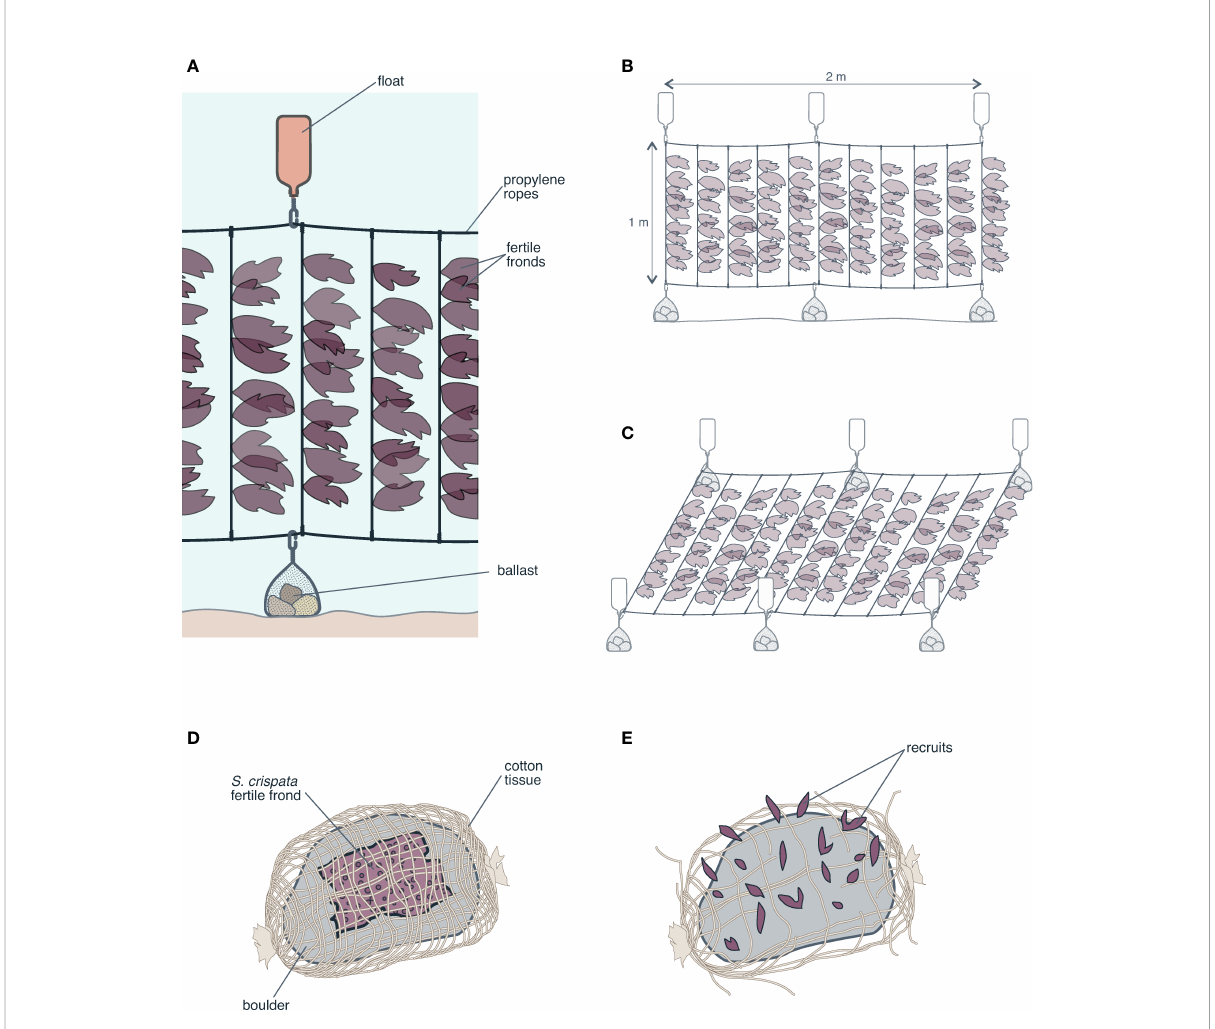
FIGURE 2 Illustration of some techniques to increase spore release from Sarcothalia crispata into the surrounding area. “ Curtains ” with blades of the seaweed are made of polypropylene ropes kept vertically between fl oats and weights, which are easy to move and reinstall elsewhere. The curtains can be installed vertically (A, B) or horizontally (C) . The latter brings the reproductive tissue closer to the substrate, reducing the excess dispersion of spores. Fragments of reproductive tissue wrapped on boulders with cotton mesh (D, E) will favor the inoculation of